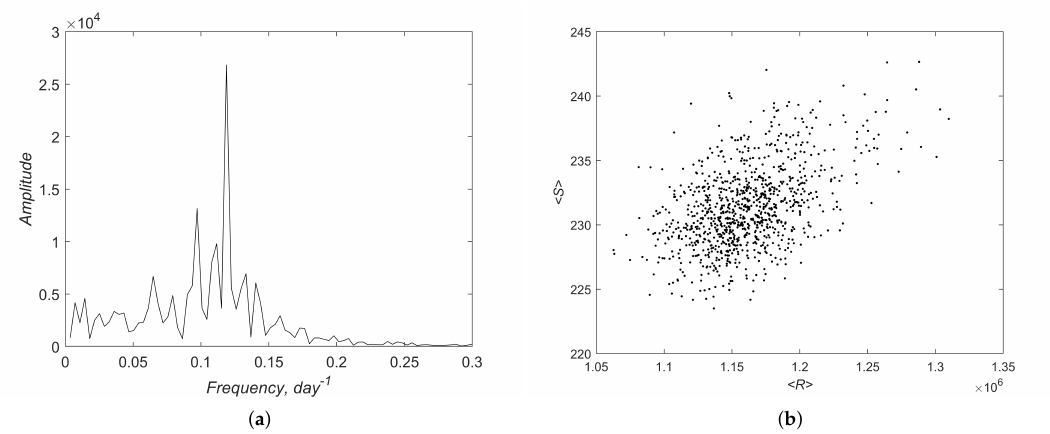
Figure 4. ( a ) The Fourier spectrum of the average prey density (cid:104) R (cid:105) . ( b ) Projection onto the phase plane ( (cid:104) R (cid:105) , (cid:104) S (cid:105) ) of the Poincaré map defined by the hyperplane N ( 50,50, t ) = (cid:104) N (cid:105)